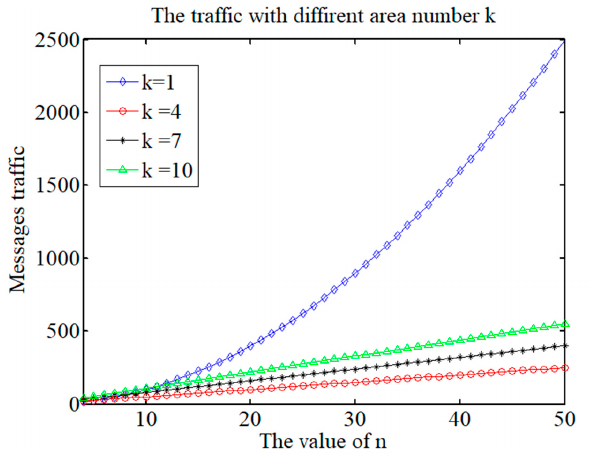
Figure 7. Traffic for various values of k .